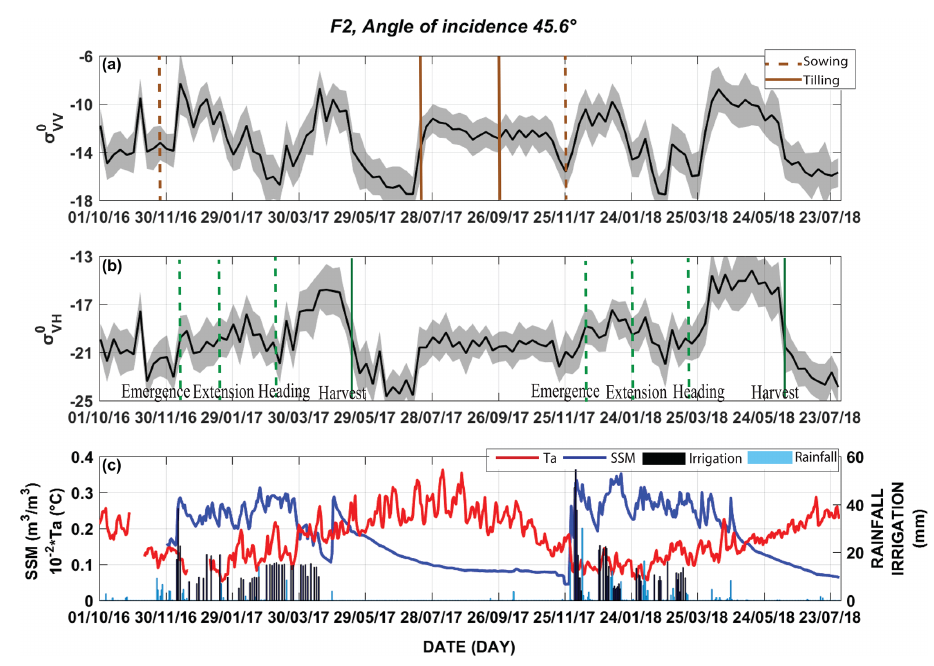
Figure 9. Time series of the backscattering coefficient at VV (a) and VH (b) polarizations on F2 at a 45.6 ◦ incidence angle during the period from 1 October 2016 to 31 July 2018. The tilling works and phenological stages of wheat are superimposed in panels (a) and (b) , respectively. The air temperature, surface soil moisture (SSM), irrigation and rainfall are displayed in panel (c) .